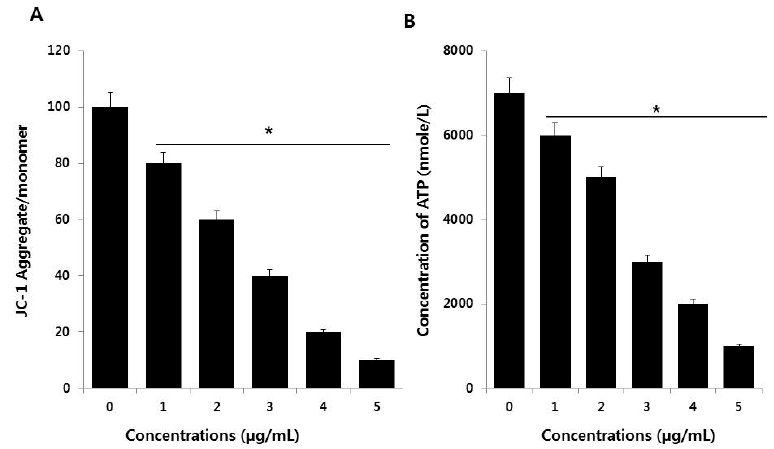
Figure 6. Measurement of mitochondrial membrane potential (MMP) ( A ) and ATP levels ( B ) in SKOV3 cells. There was a significant difference in the ratio in PdNPs-treated cells compared to that for in untreated cells, as determined by the Student’s t -test (* p < 0.05).